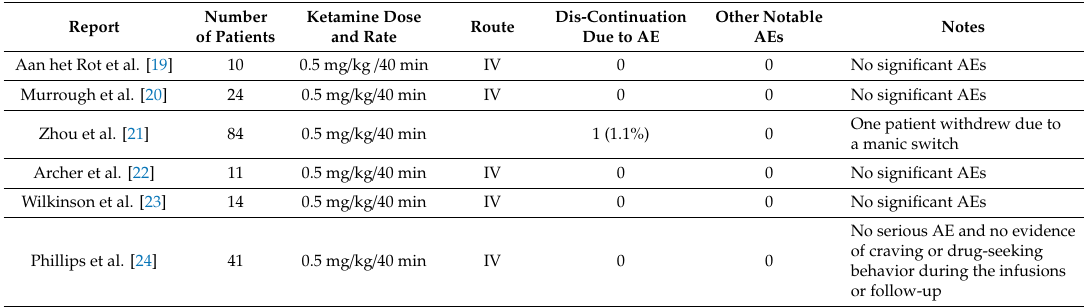
Table 3. Adverse events (AE) reported in published papers describing treatment of depression with six or more repeated infusions of